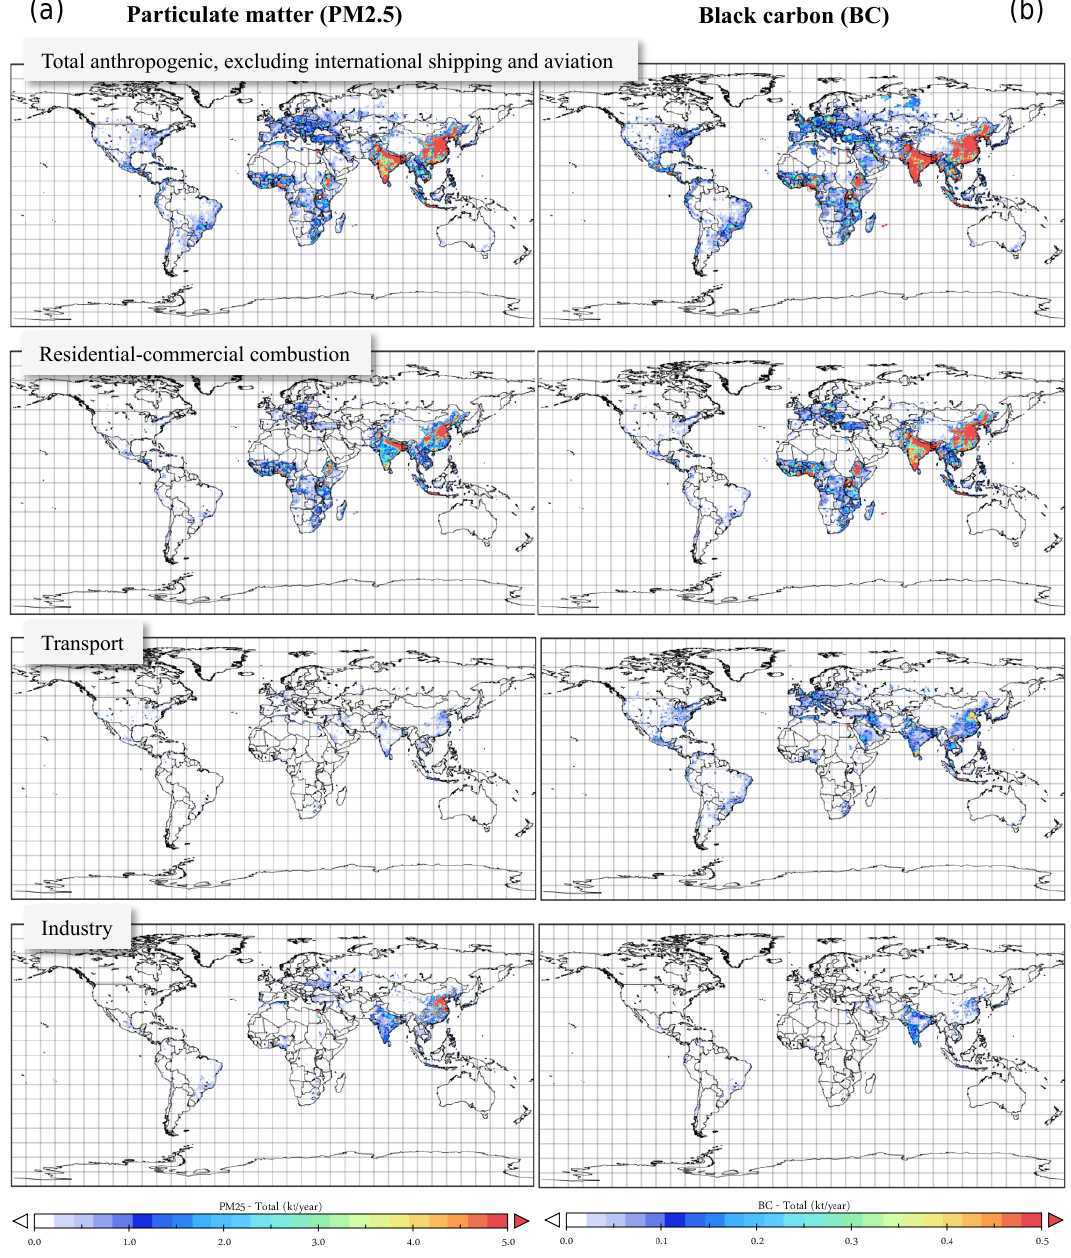
Figure 8. Global distribution of emissions of PM 2 . 5 (a) and BC (b) in 2010 (Ggyear − 1 per grid) from land-based sources, ECLIPSE V5a ; the scale is the same across sectors but there is a factor of 10 difference between PM 2 . 5 and